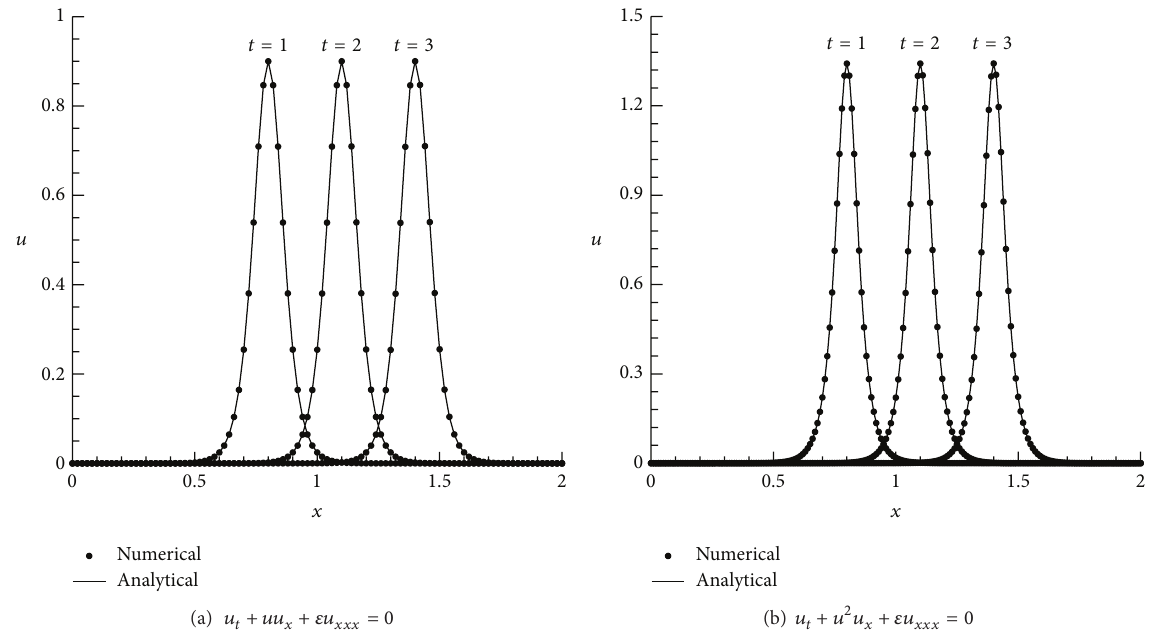
Figure 4: Numerical and analytical solutions for equation 𝑢 𝑡 +𝑢 2 𝑢 𝑥 +𝜀𝑢 𝑥𝑥𝑥 = 0 and 𝑢 𝑡 +𝑢 2 𝑢 𝑥 +𝜀𝑢 𝑥𝑥𝑥 = 0 of Example 4 at various time stages. Table 5: Error norms at different time stages for equation 𝑢 𝑡 + 𝑢𝑢 𝑥 + 𝜀𝑢 𝑥𝑥𝑥 = 0 , with initial condition (38) for 𝑛 = 1 , 𝑑𝑥 = 0.02 , and 𝑑𝑡 = 0.25 × 𝑑𝑥 2 . 𝑇 Present Dehghan and Shokri [14]